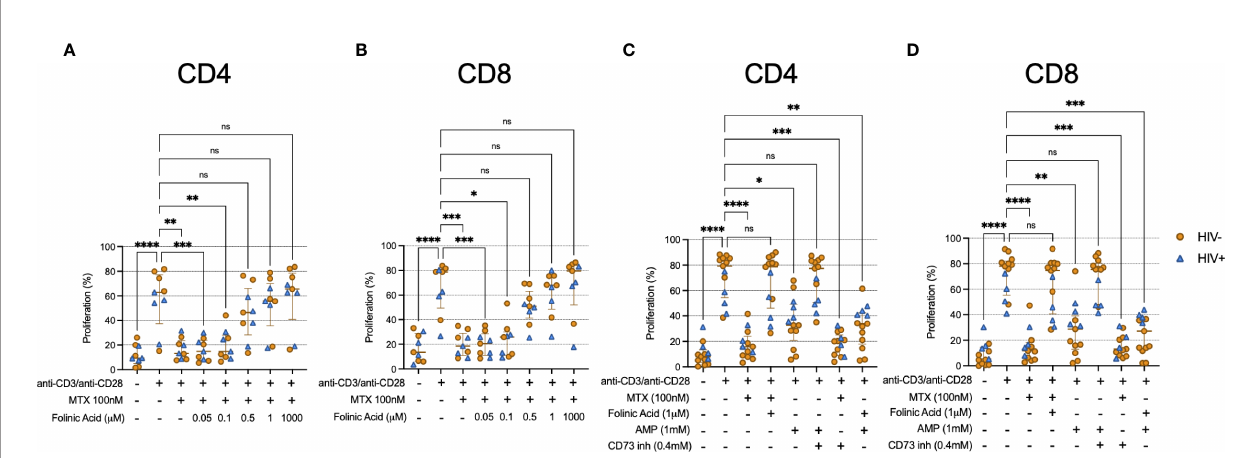
FIGURE 4 | Folinic acid restores proliferation inhibited by MTX. (A, B) Cryopreserved PBMCs from PWH (blue triangles, n=4) or HIV-uninfected donors (gold circles, n=5) were labeled with CellTraceViolet (CTV) then stimulated for 4 days with anti-CD3/anti-CD28 in the presence or absence of MTX (100nM) and folinic acid (0.05 – 1000 m M). At the end of the culture, CD4 (A) and CD8 (B) T cells were analyzed by fl ow cytometry for CTV dilution. (C, D) Cryopreserved PBMCs from PWH (blue triangles, n=4) or HIV-uninfected donors (gold circles, n=9) were labeled with CellTraceViolet then stimulated for 4 days with anti-CD3/anti-CD28 (TCR) in the presence or absence of MTX (100nM), folinic acid (1mM), adenosine monophosphate (AMP, 1mM), or CD73 inhibitor (0.4mM). At the end of the culture, CD4 (C) and CD8 (D) T cells were analyzed by fl ow cytometry for CTV dilution. Statistical signi fi cance determined among all groups using nonparametric paired Friedman ’ s test. ns, not signi fi cant; *P < 0.05; **P < 0.01; ***P < 0.001; ****P <